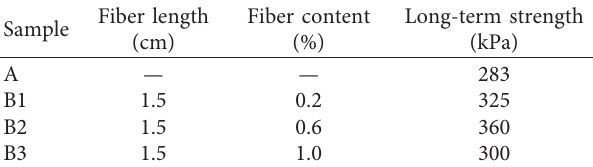
Table 3: Long-term strength of different samples. Sample